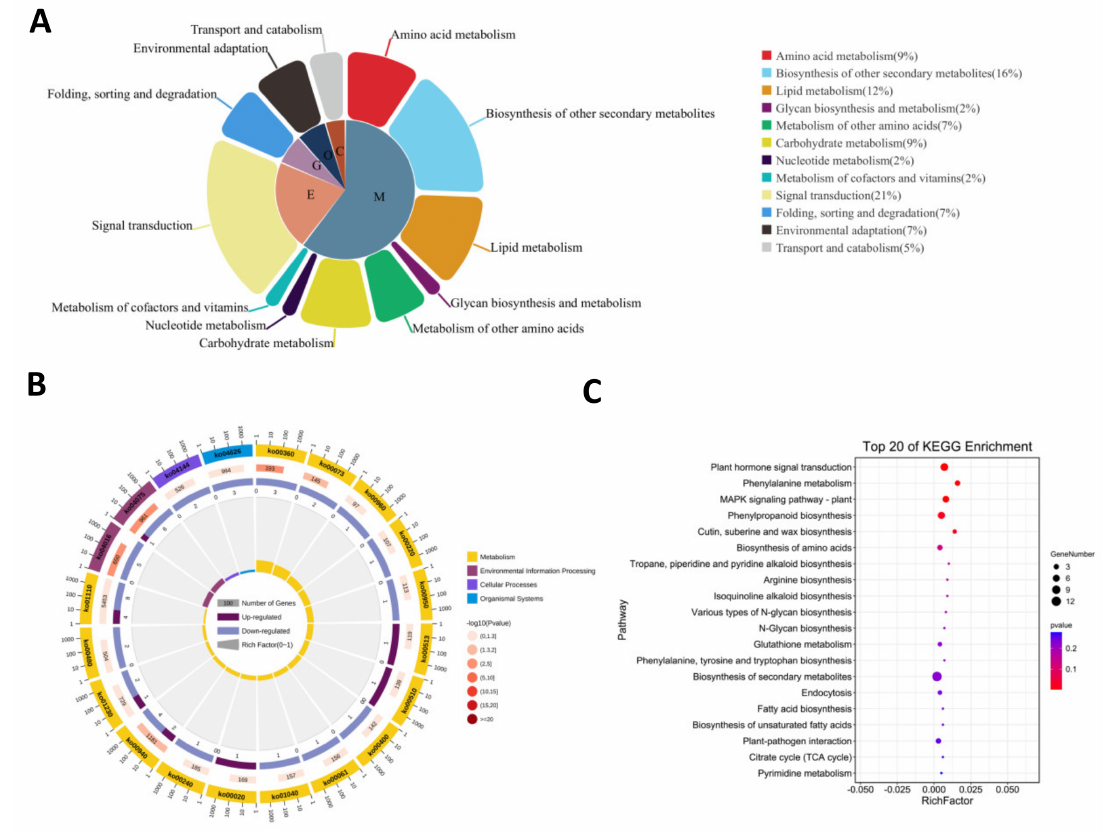
Figure 6. Primary and secondary classification ( A ) and the top 20 significantly enriched pathways based on KEGG ( B , C ). C: cellular processes; O: organismal systems; G: genetic information processing; E: environmental information processing; M: